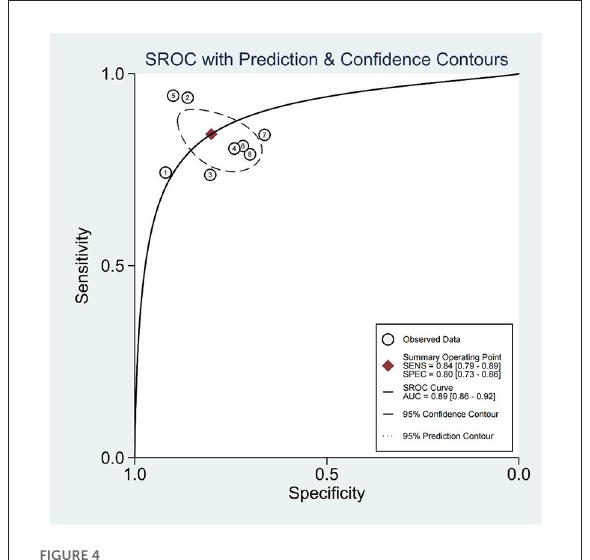
FIGURE4 ROC curve of miRNA for diagnosis of HTN with LVH.